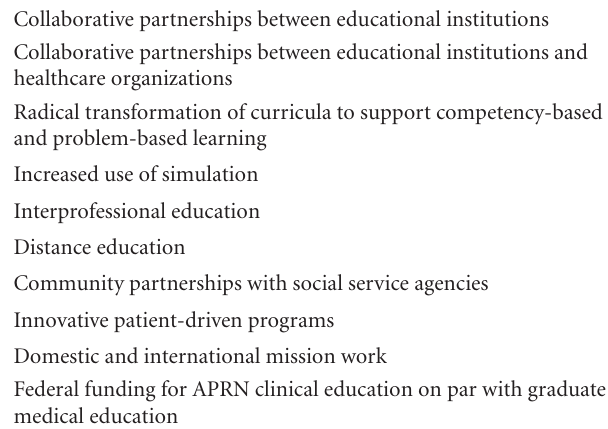
Table 2: Solutions and